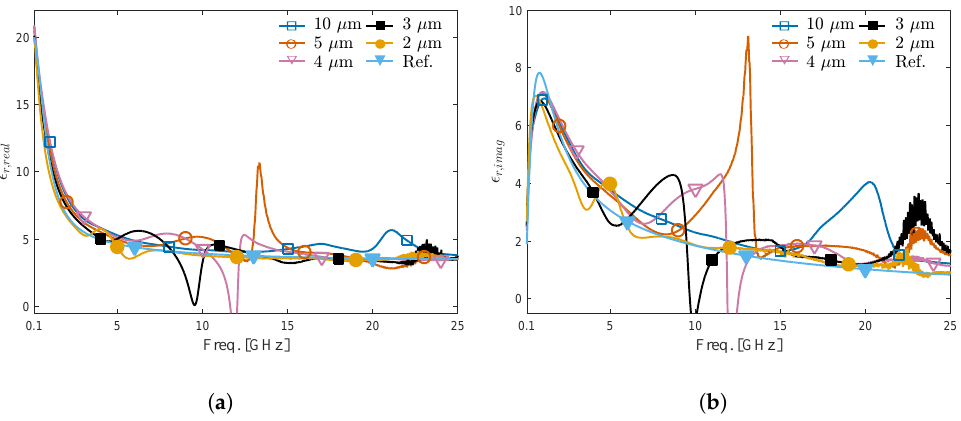
Figure 7. Extracted permittivity using IDCs with different electrode widths compared with reference permittivity for DI water/IPA Mixture with IPA volume fraction 80% . ( a ) Real part. ( b ) Imaginary part.